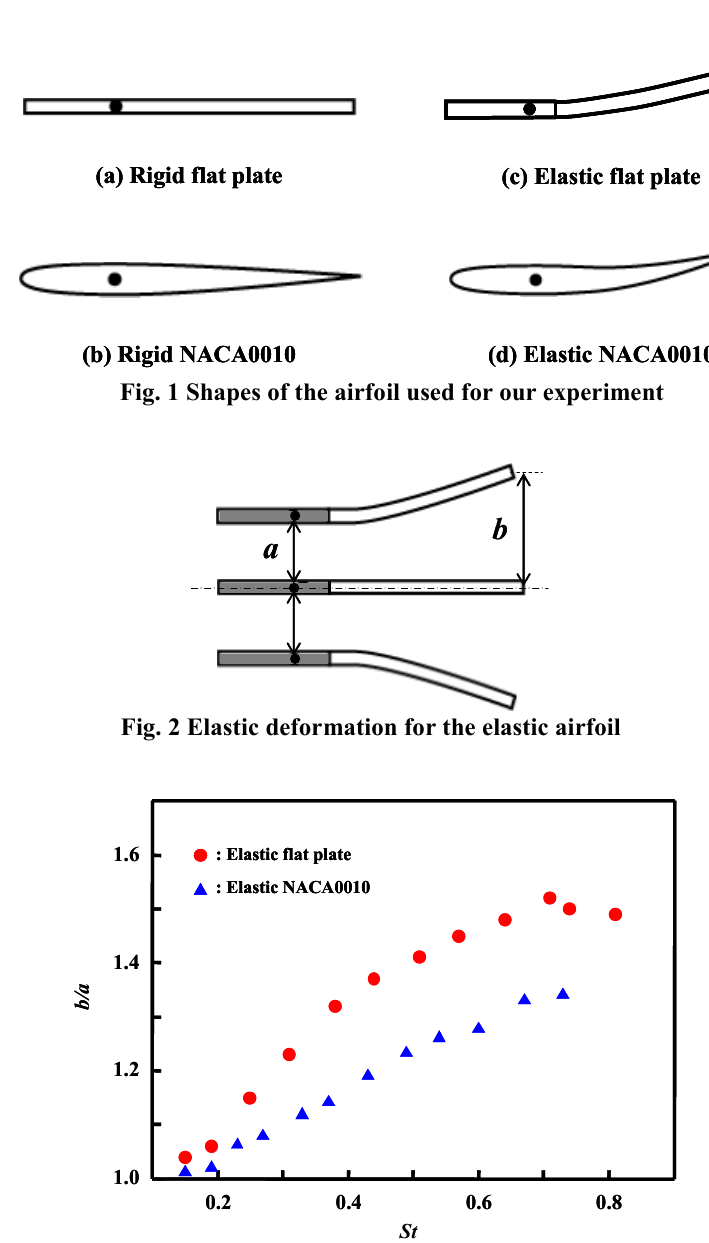
Fig. 3 Deformation volume of the trailing edge of the elastic flat plate and elastic NACA0010 in the